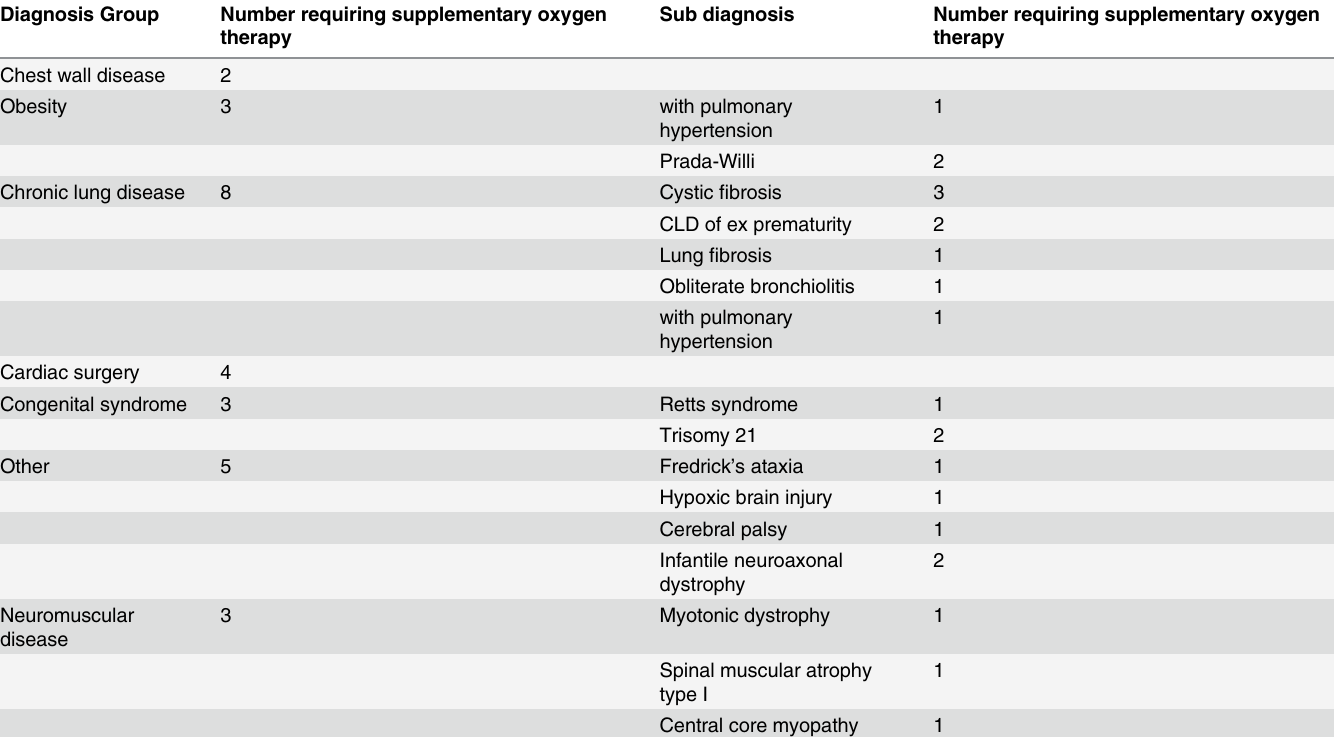
Table 3. Number of patients who required oxygen therapy by disease group and individual diagnosis.